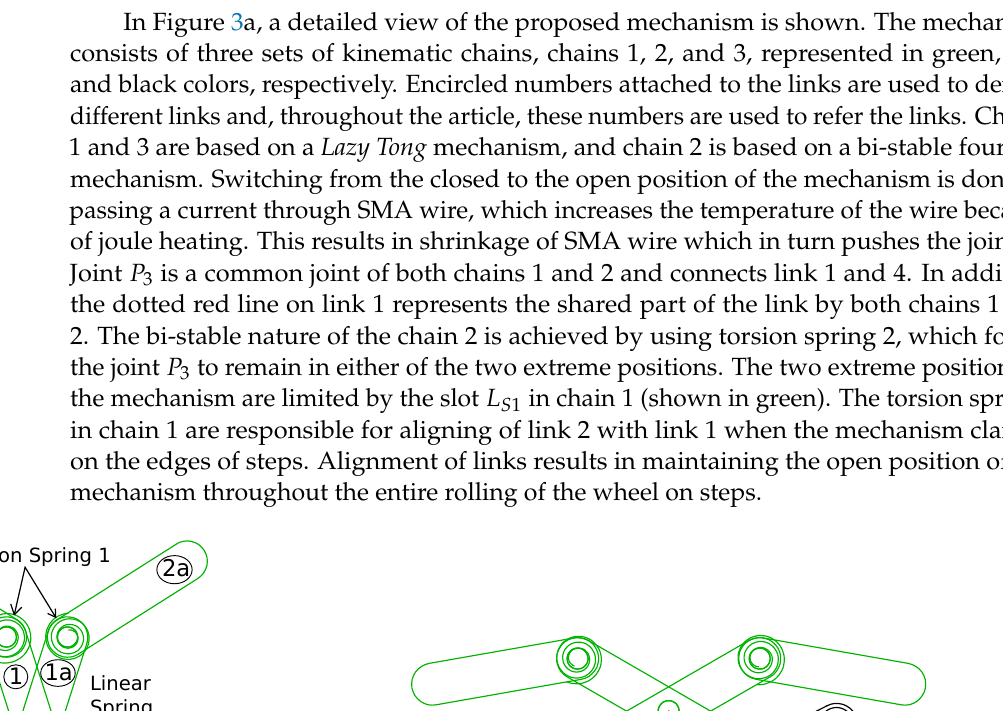
Figure 2. Working principle of an anti-slip mechanism ( a ) while climbing on stairs; ( b ) while climbing down stairs.